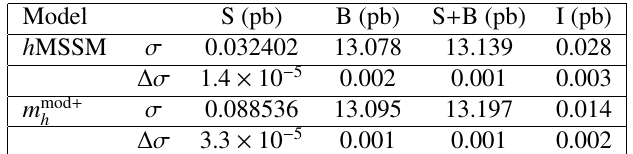
Table 1. Parton level results for the h MSSM and m mod +